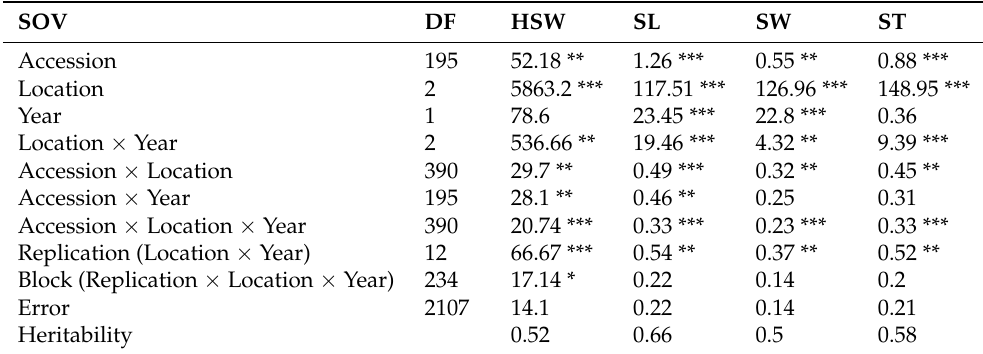
Table 1. Mean squares from analysis of variance for four seed size traits of 196 accessions of African yam bean evaluated at three test locations in